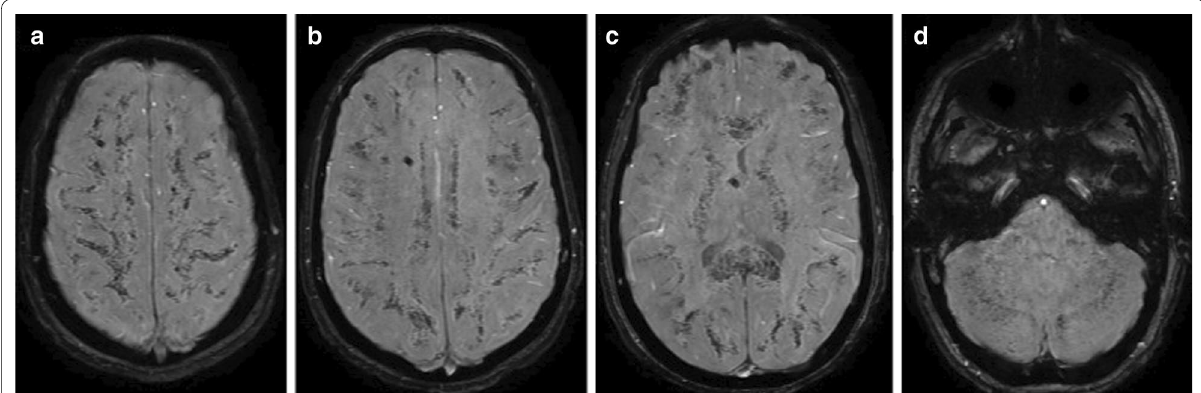
Fig. 4 A case representing the walnut kernel microbleed pattern. SWI ( a – d ) MRI images at the level of the centrum semiovale ( a ), at the level of the corona radiata ( b ), at the level of the basal ganglia ( c ), and at the level of the brainstem and the cerebellum ( d ) of a 16-year-old polytraumatised female patient acquired on day 12 after hospital admission. SWI shows very high number of monotonous punctuate microbleeds in the subcortical white matter, the internal capsule, the corpus callosum, the cerebellum and the brainstem resembling a “walnut kernel”. The larger hypointensity visible in the right centrum semiovale and near the third ventricle is due to a ventricular drain ( a – c )